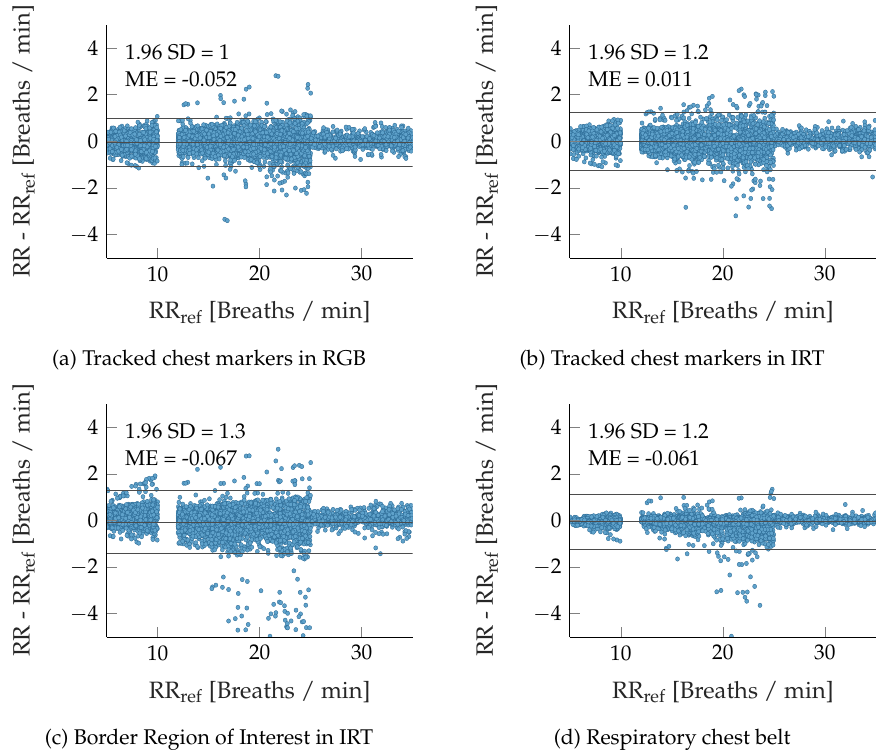
Figure 11. Bland–Altman diagrams for extracted respiratory